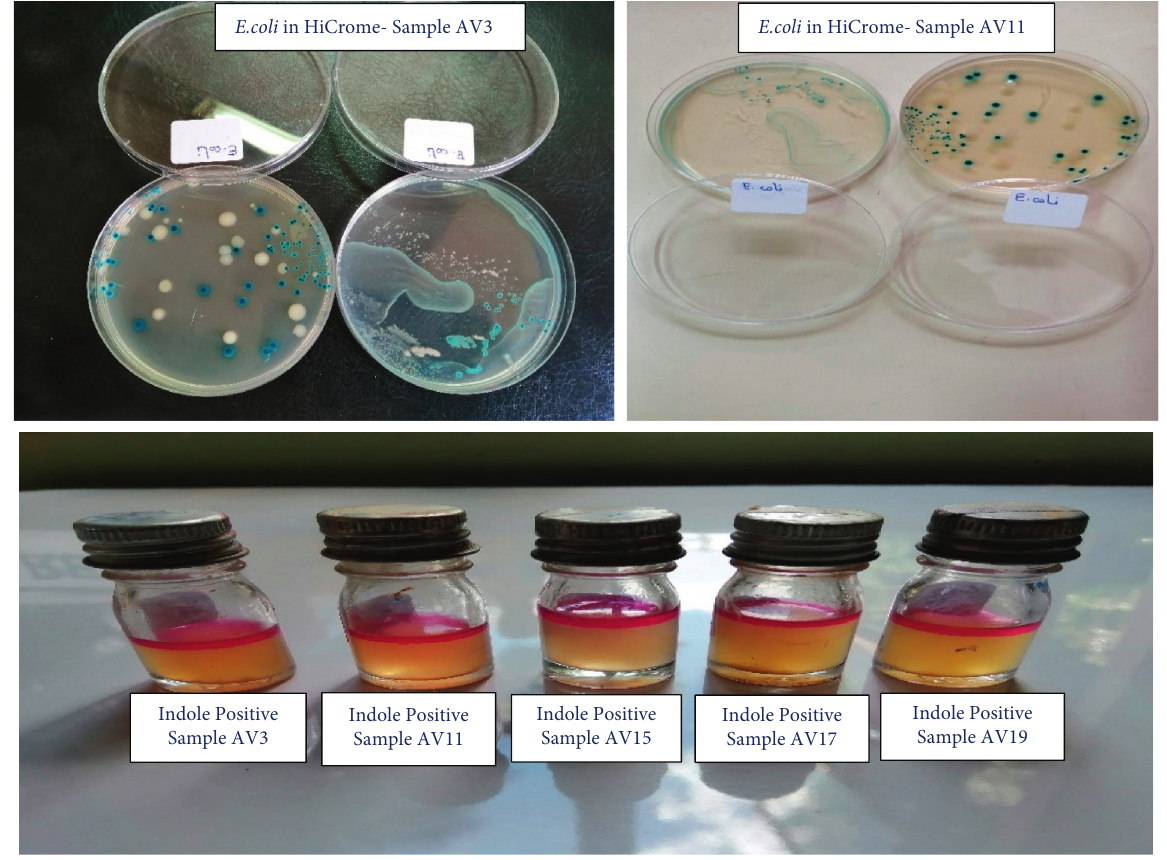
Figure 9: Escherichia coli on HiCrome chromogenic media and indole